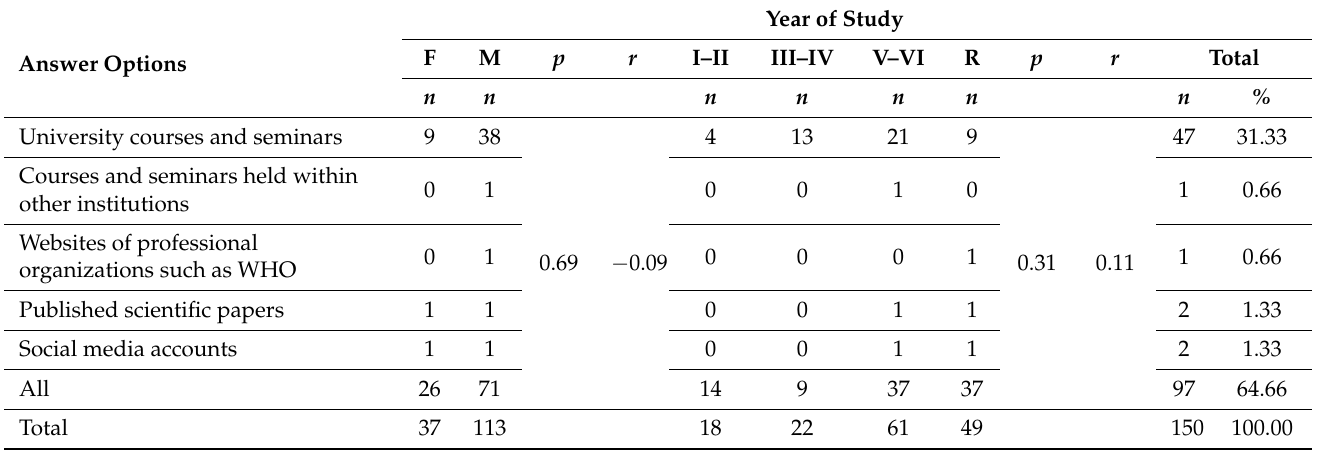
Table 7. Frequency distribution of answers to question Q21 = “Where did you get the most informa- tion about infection transmission, prevention and control?” by gender and year of